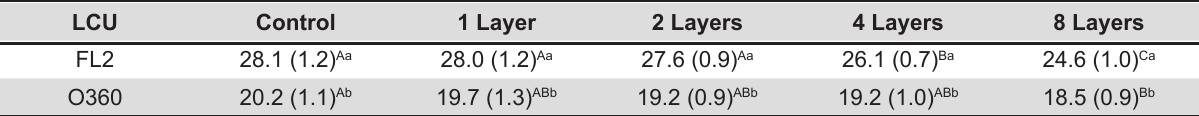
Table 1- Means (standard deviations) of Vickers hardness number (VHN) of the upper surface of composite resin specimens light cured with light curing units covered with layers of an infection control barrier